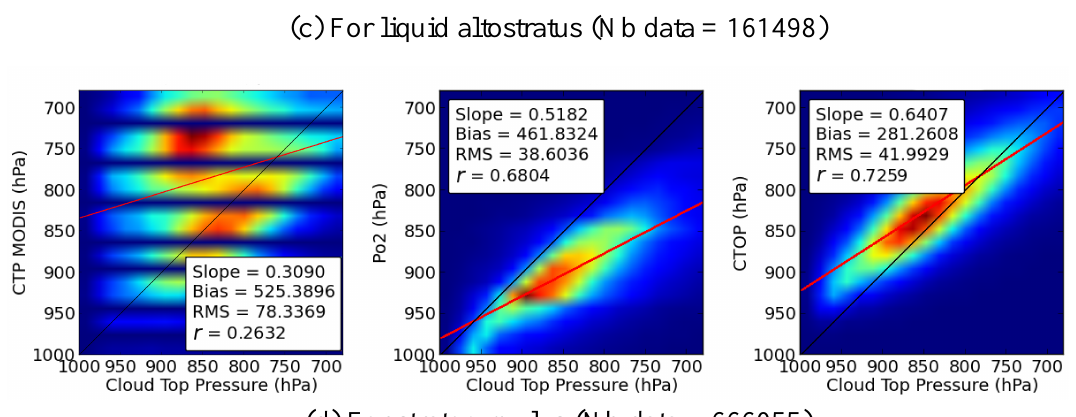
Fig. 8. Evaluation of MODIS cloud top pressure (CTP MODIS, left-hand panels), POLDER cloud oxygen pressure ( P O cloud top oxygen pressure (CTOP, right-hand panels), versus CPR/CALIOP cloud top pressure (in abscissa). Cases over ocean in 2008. The number of data, Nb data, is given for each cloud type. Stripes in left-hand panels come from the very discrete values taken by MODIS